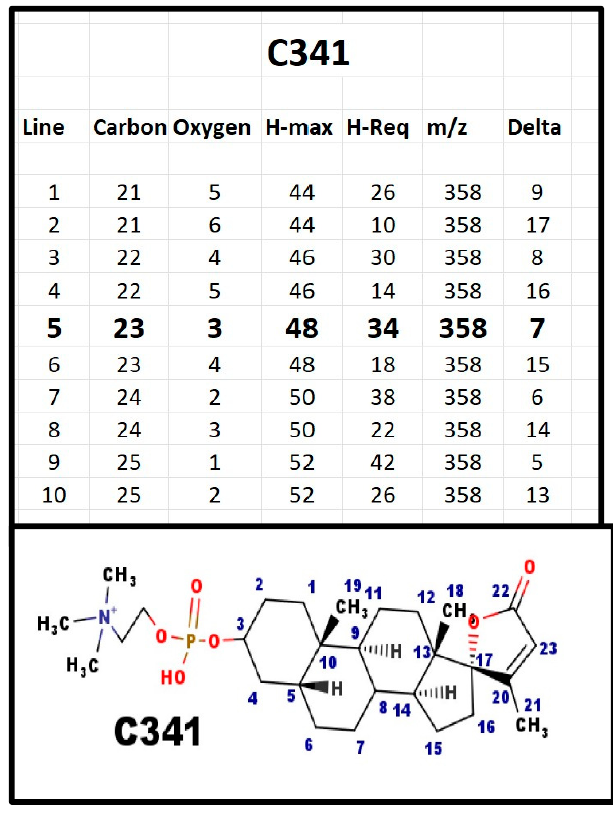
Figure A5. The proposed structures of C341